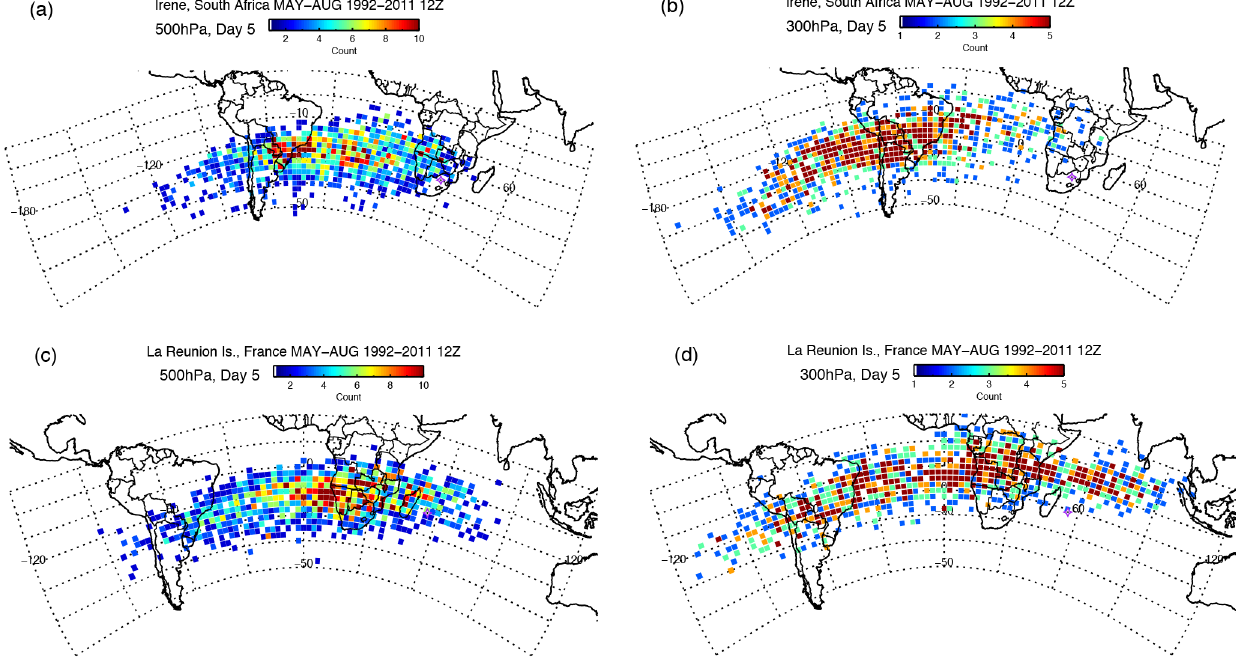
Figure 12. Air mass origins of free-tropospheric ozone over Irene (a) for the sonde launch time at 500hPa, (b) for 300hPa) and Réunion (c, d) . Five-day back trajectories run using NCEP/NCAR re-analysis in the NASA/Goddard kinematic model. The ending points are summed up for a 1 ◦ × 1 ◦ grid. Note different color bars for the two